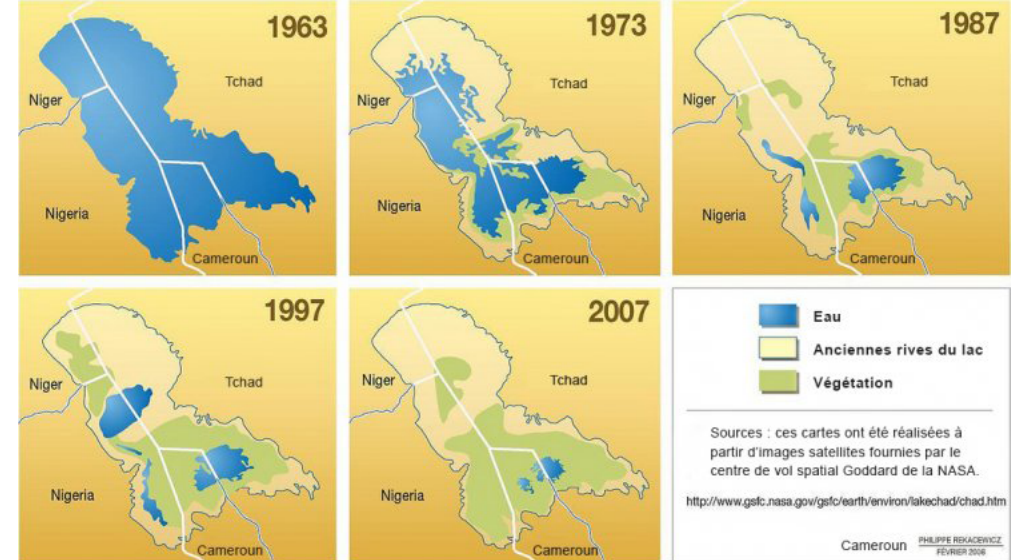
Tableau 1. Les stratégies d’adaptation de gestion rationnelle des ressources en eau (Source : Enquête de terrain, 2012). Systèmes Impact du CC Pratiques endogènes d’adaptation au